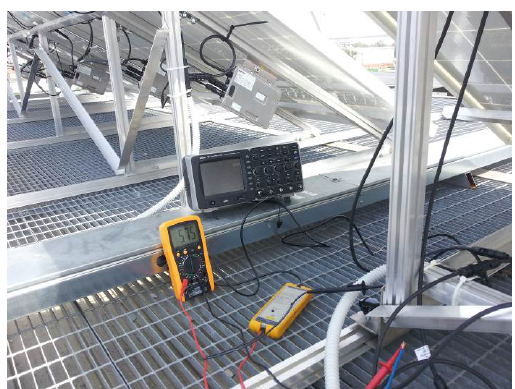
Figure 15. Measurement setup of the DC current generated by the PV